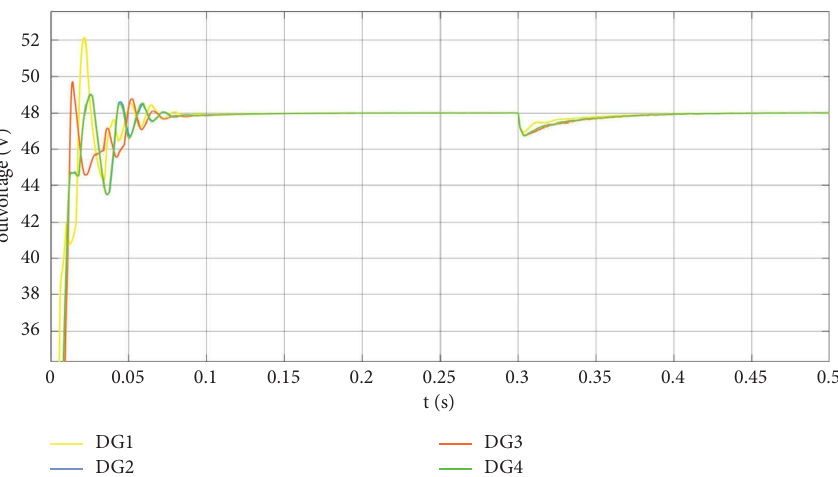
Figure 9: Output voltage under resistance load change.